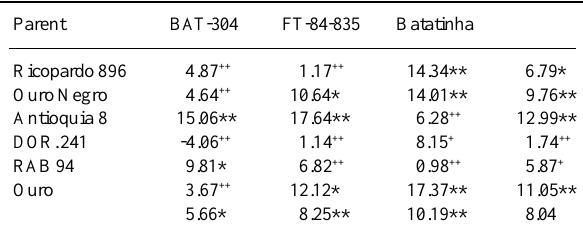
Table IV - Estimates of specific (central values), varietal in group 1 (vertical marginal values), varietal in group 2 (horizontal marginal values) and mean (lower right hand side) heteroses, for grain yield of common beans, in grams, and significance levels for tests of the